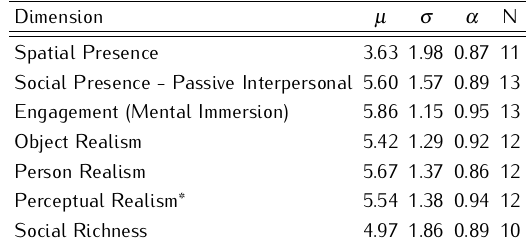
Table 10. Summary of response among the presence dimensions in the TPI. The Perceptual Realism combines Object Realism and Person Real- ism.